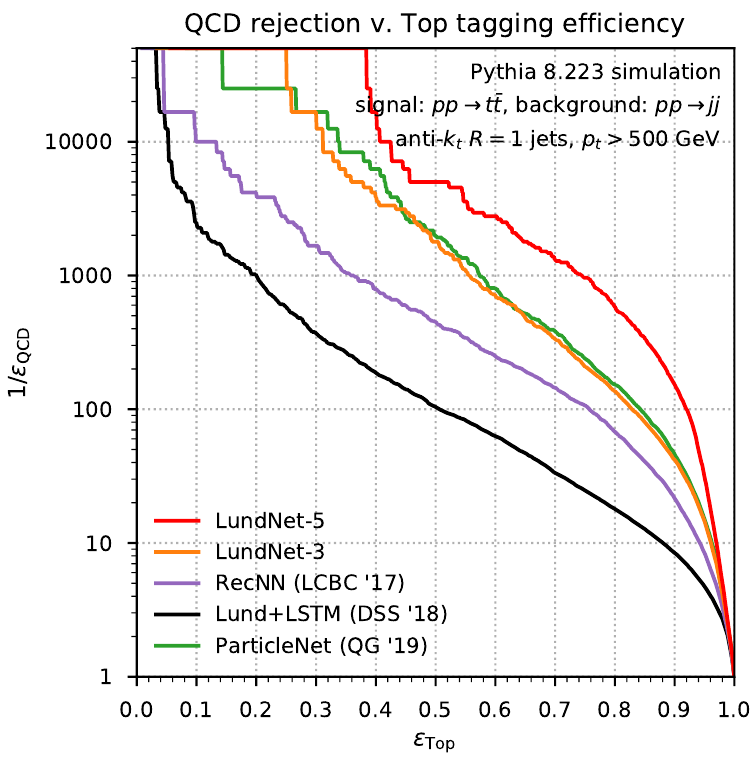
Figure 6 . Background rejection 1 /(cid:15) QCD versus signal efficiency (cid:15) Top for top jet tagging with transverse momentum p 500 t >